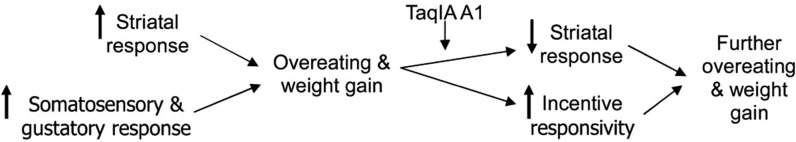
Dynamic vulnerability model of obesity. TaqIA refers to the single-nucleotide polymorphism of the ANKK1 gene (rs1800497), which has 3 allelic variants: A1/A1, A1/A2, and A2/A2.